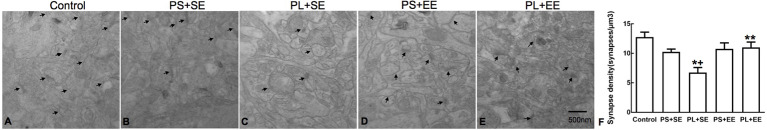
Transmission electron microscopy of synaptic ultrastructure. (A–E) Representative images of synaptic ultrastructure from hippocampus of different groups. (F) Summary data of synaptic numbers in the hippocampus of elderly rat offspring. Arrows indicate the number of synapses (A–E). Data are expressed as mean ± SEM, n = 4 per group, *p < 0.05, PL + SE group vs. control group; +p < 0.05, PL + SE group vs. PS + SE group; **p < 0.05, PL + EE group vs. PL + SE group.